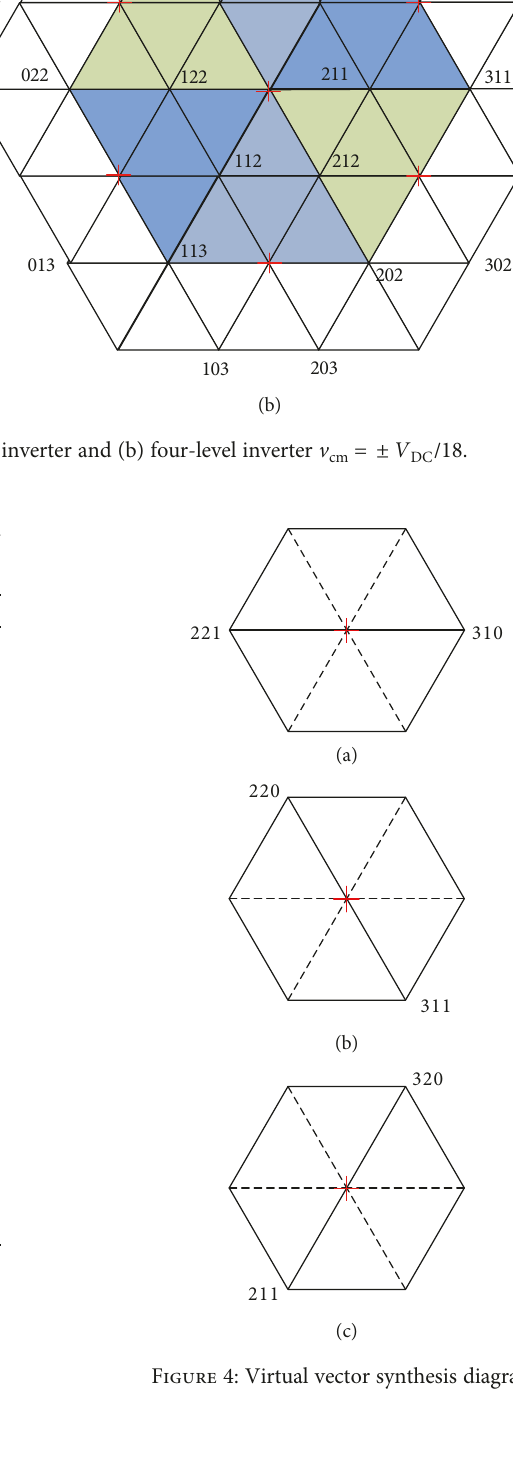
Figure 4: Virtual vector synthesis